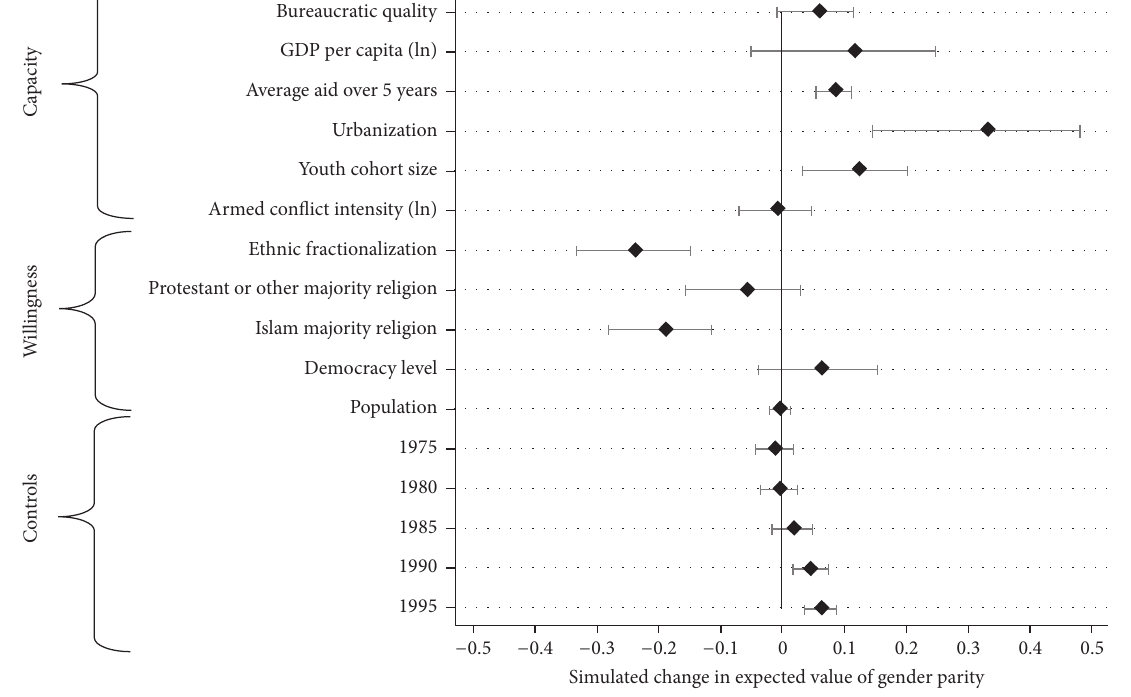
high urbanization levels (95th percentile), the gender parity score increases by 0.27 units. This finding that urbanized countries exhibit higher relative female secondary education levels indicates support for the capacity argument.